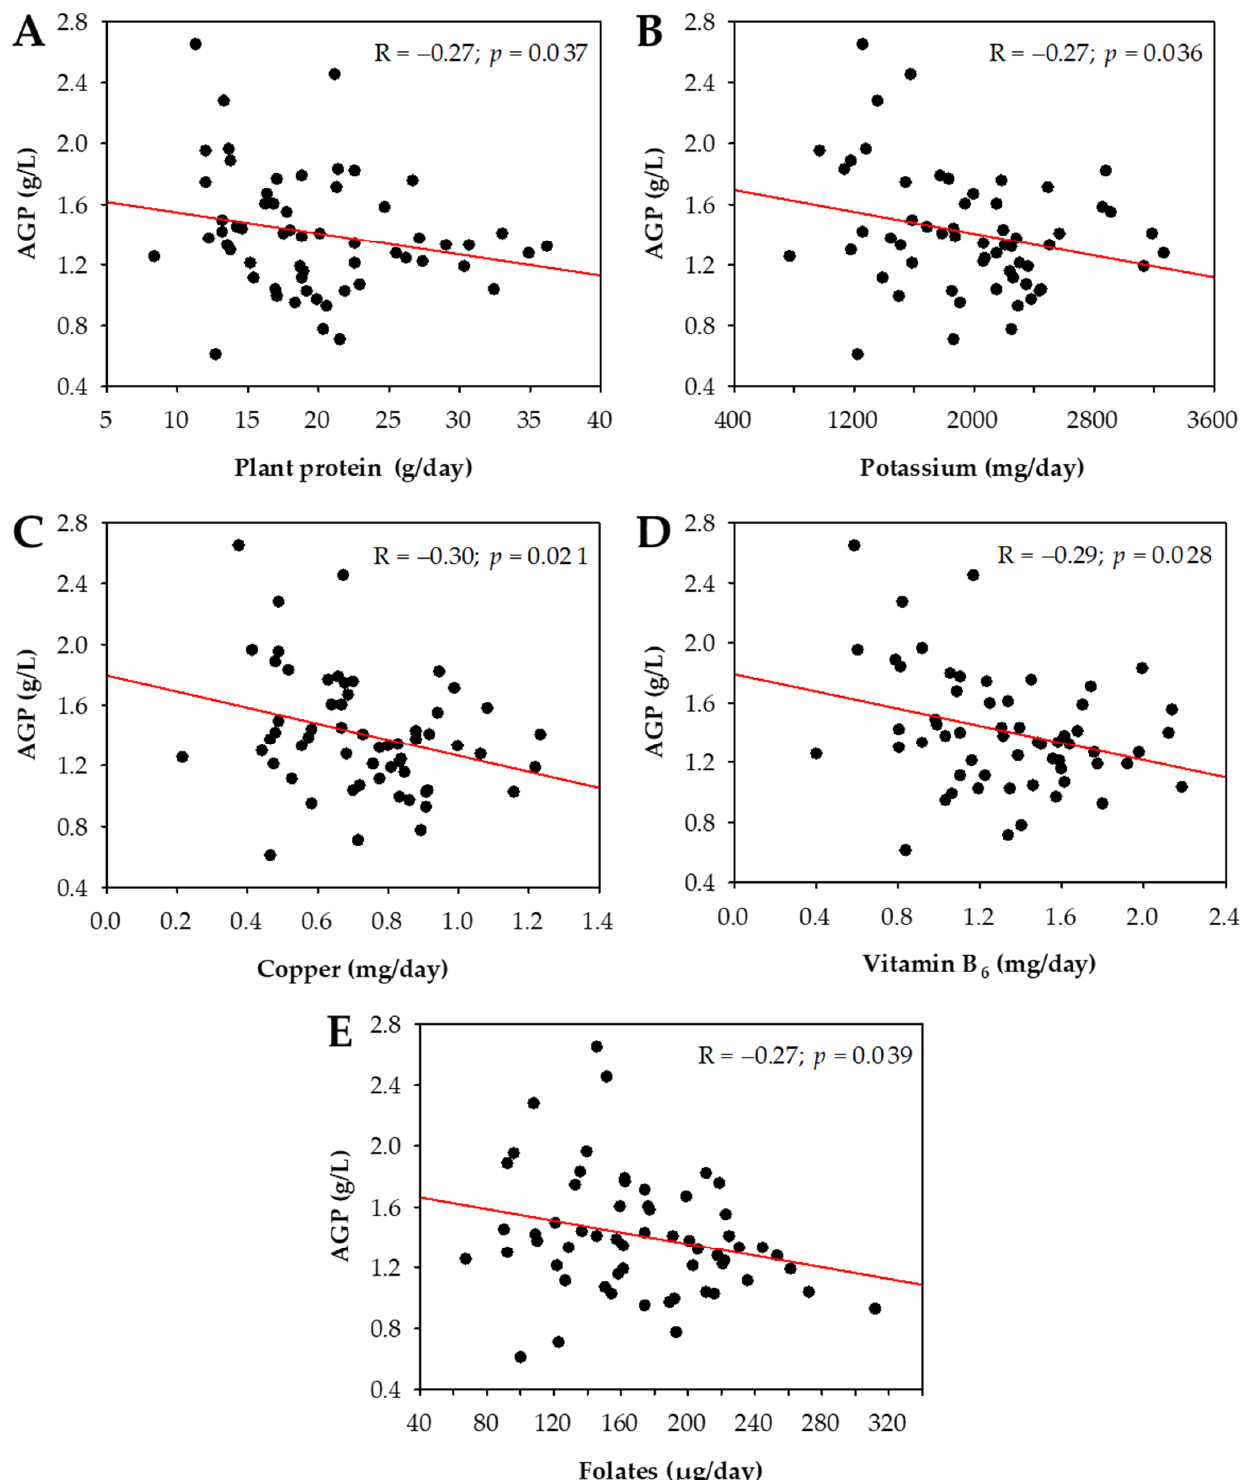
Figure 1. Correlations between serum concentrations of AGP and the intake of selected nutrients based on 24 h recall: plant protein ( A ), potassium ( B ), copper ( C ), vitamin B 6 ( D ), and folates ( E ). Data are presented as arithmetic means of values obtained in post-summer and post-winter assessment.